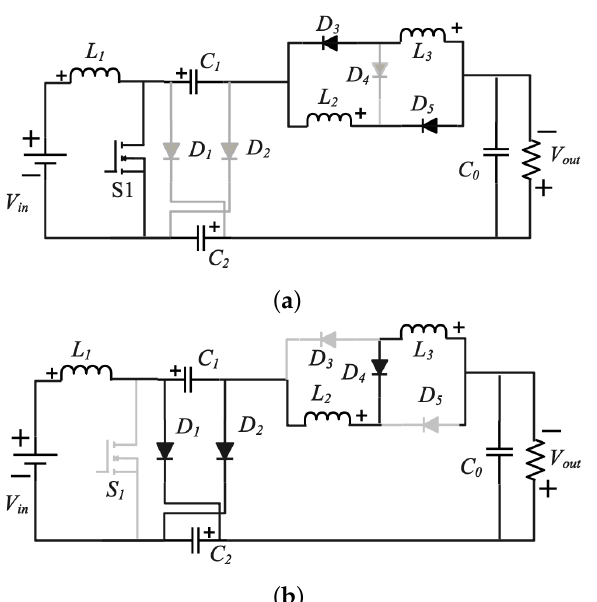
Figure 7. Topology 2: Operating mode of SLSC CUK converter ( a ) ON Mode ( b ) OFF